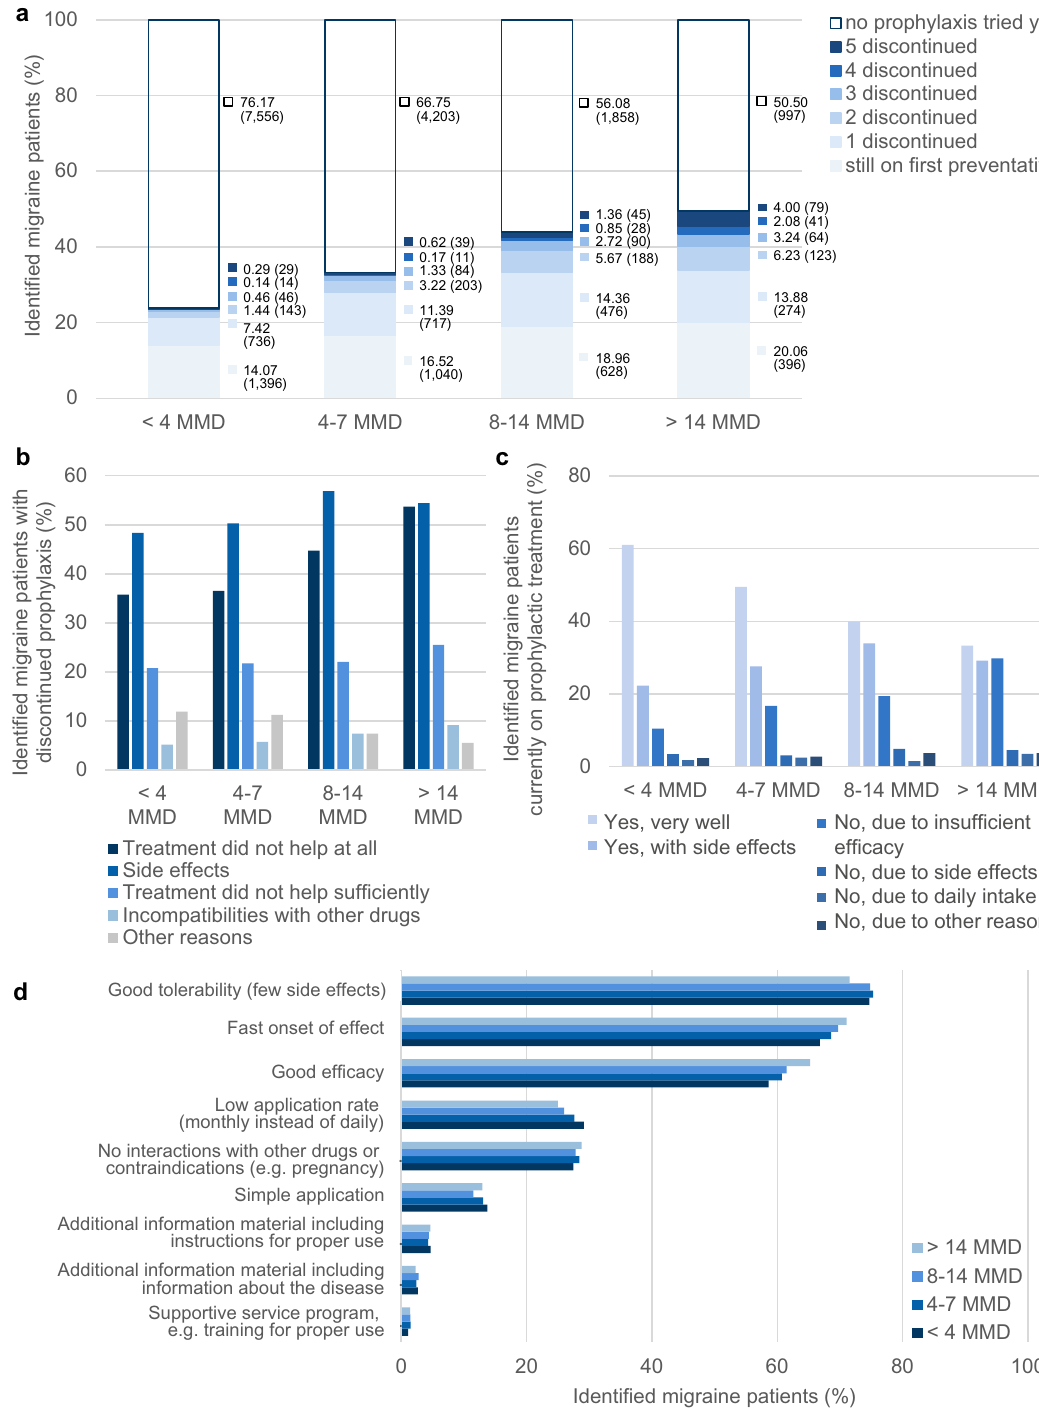
Figure 4. Prophylactic treatments. ( a ) Graph shows the percentages of identified migraine patients that have tried 0–5 different prophylactic treatments depending on their MMD; respective percentages are depicted in the graph (absolute number of patients in brackets). ( b ) Shown are reasons for discontinuation of preventive treatments depending on the patients’ number of MMD. All patients who had previously discontinued at least one preventive treatment (N = 3430) were asked for their reasons (multiple reasons per patient were allowed). ( c ) Graph shows satisfaction of identified migraine patients with their current prophylaxis depending on the number of their MMD. ( d ) Depicted are the patients’ demands on a new prophylactic migraine treatment depending on their number of